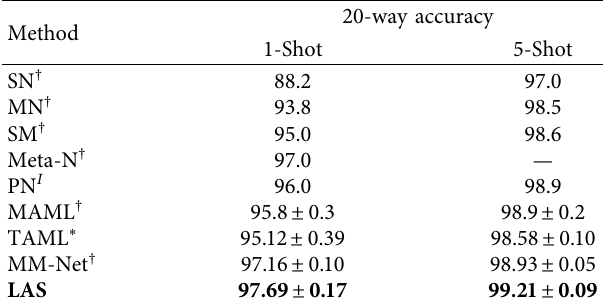
Table 3: Mean accuracy (%) ± CIs (%) of 8 state-of-the-art methods and LAS on the Omniglot dataset with Conv-4 as the backbone.